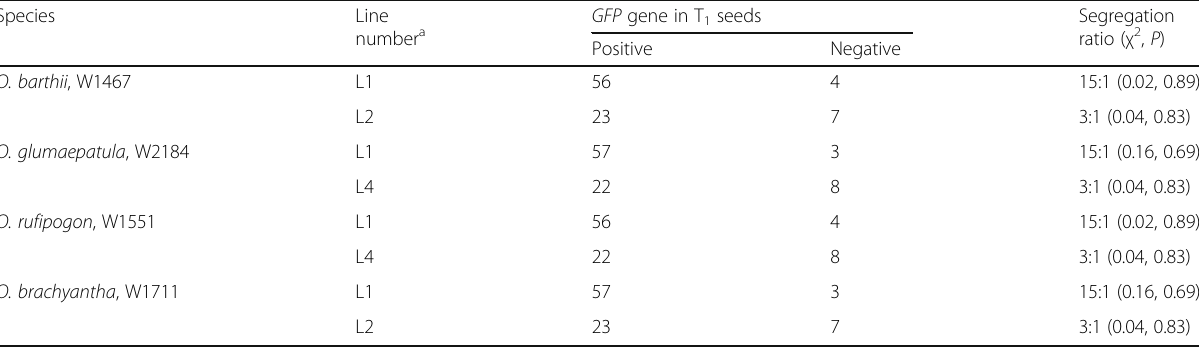
Table 7 Inheritance and segregation of the transgenes Species Line